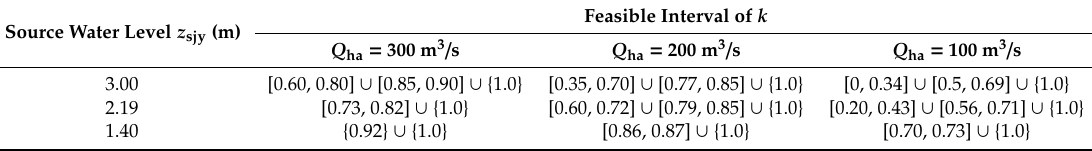
Table 3. Feasible interval of k under the constraints of water level and flow